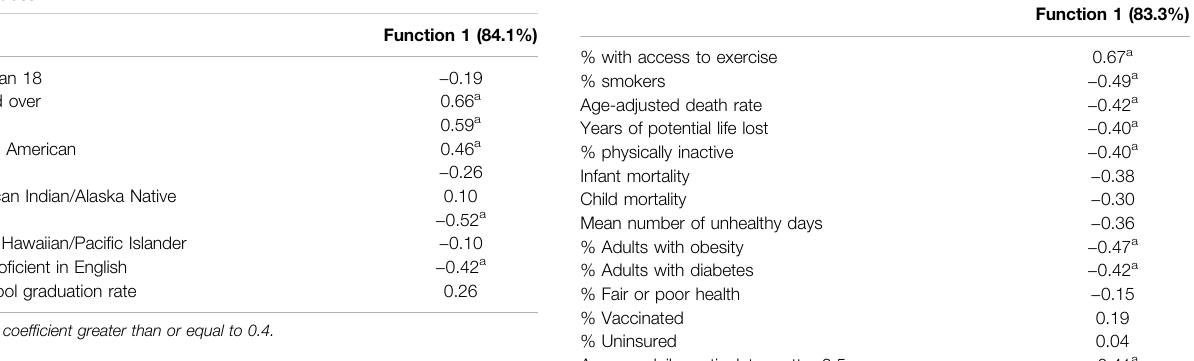
TABLE 4 | Discriminant analysis structure coef fi cients for demographic variables by latent class.